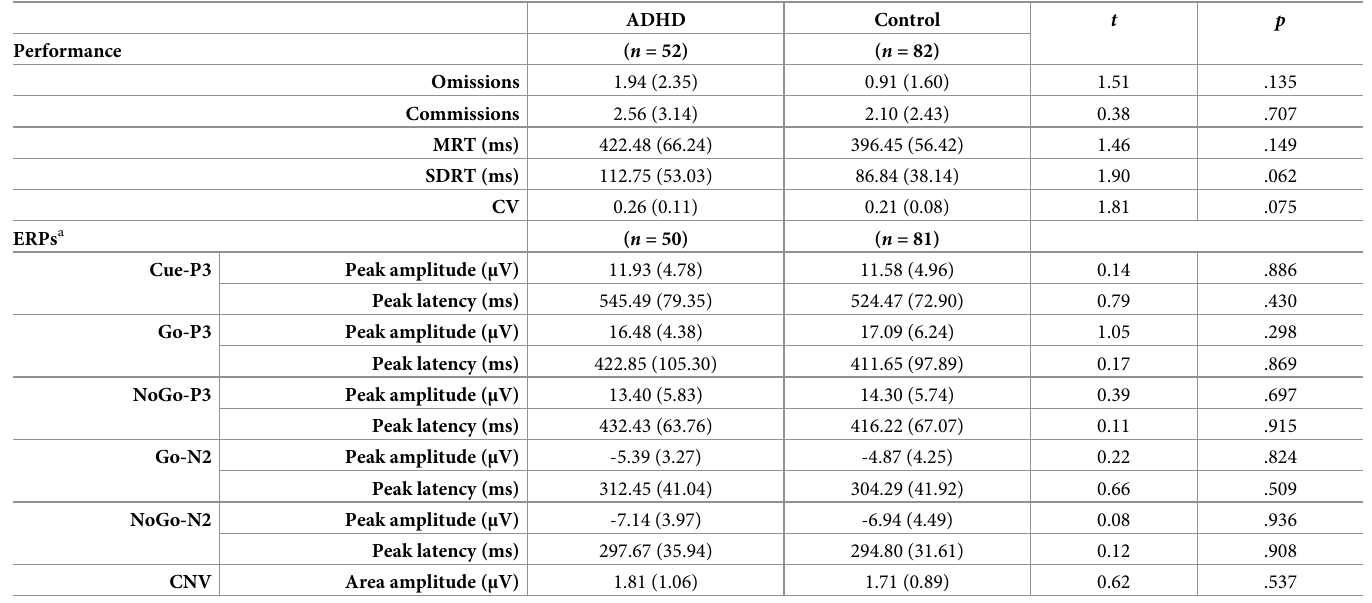
Table 2. Summary statistics and mean comparisons for performance scores and ERPs on the flanked CPT controlling for age, IQ and genetic-relatedness.